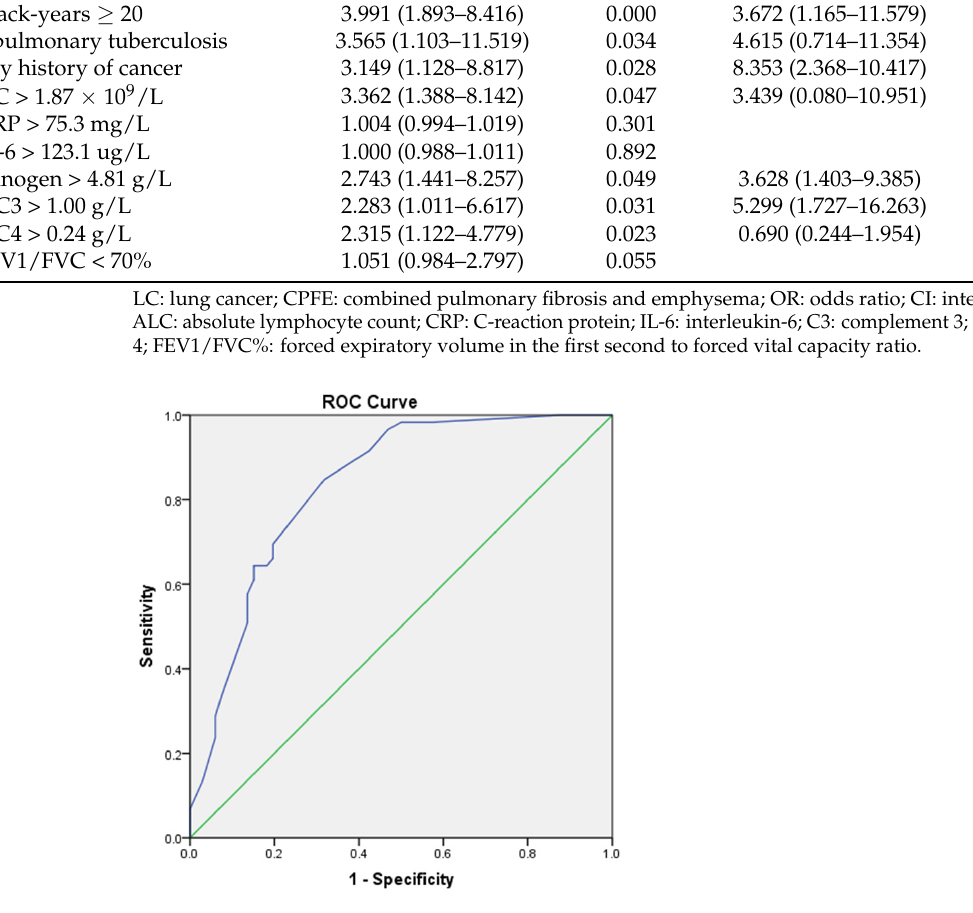
Figure 2. The ROC curve of the logistic model including 4 variables of pack-years ≥ 20, family history of cancer, fibrinogen and C3 is shown, with an AUC of 0.844 (95% CI: 0.776–0.913). The sensitivity of this model was 94.9% and the specificity was 63.1%. Table 3. Univariate and multivariate analyses of independent factors for the presence of LC in patients with CPFE.